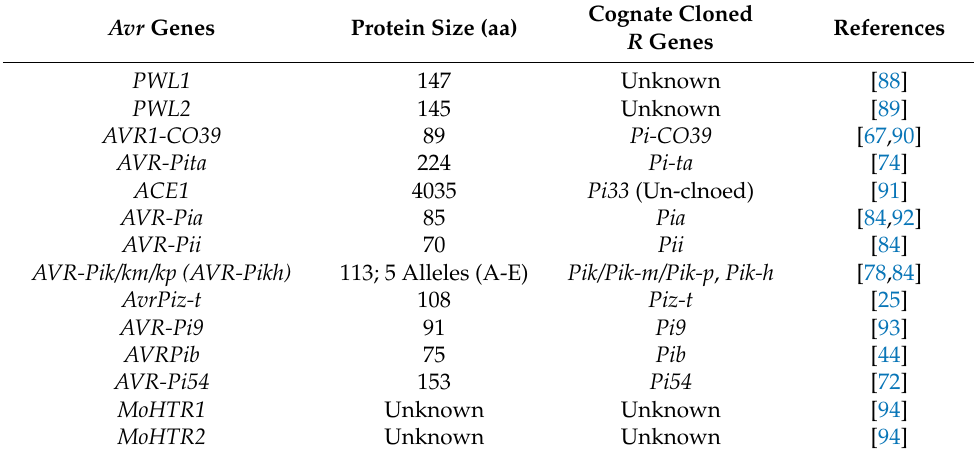
Table 2. List of all cloned Avr